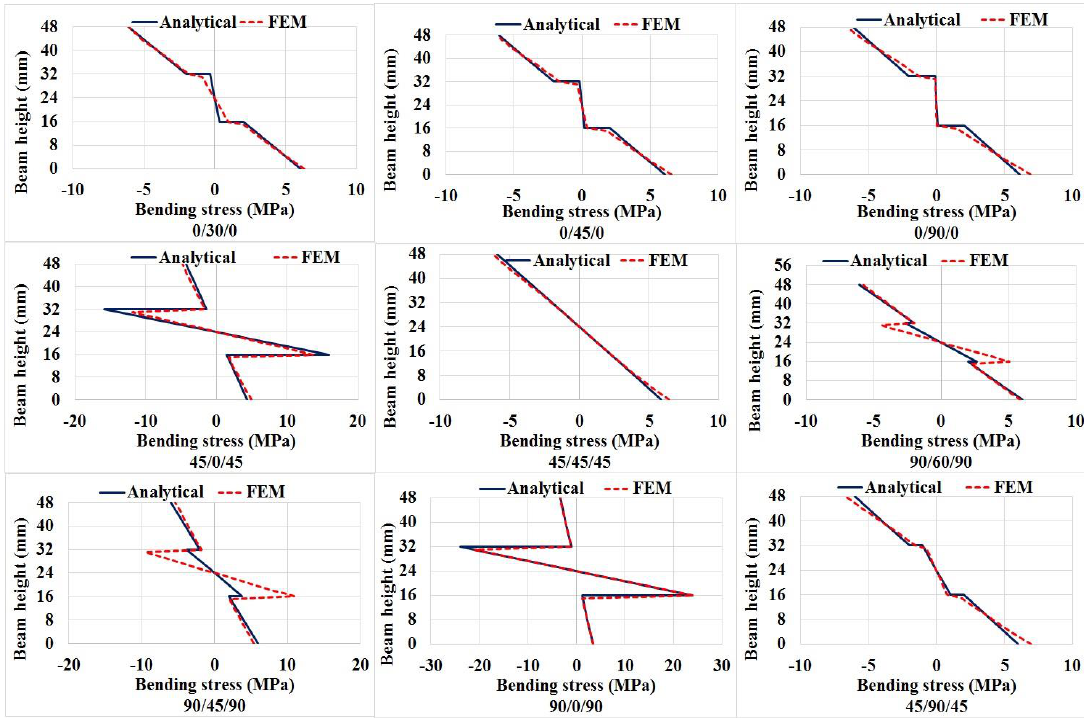
Figure 7. Deformation and stress distribution in CLT panel using the FEM method.